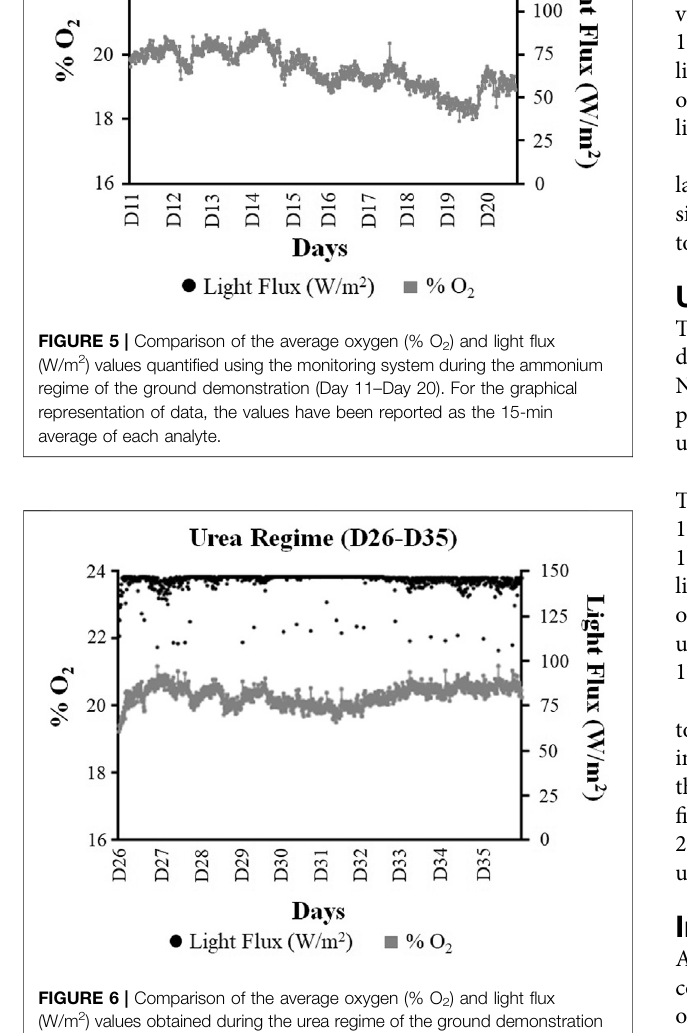
Frontiers in Astronomy and Space Sciences |